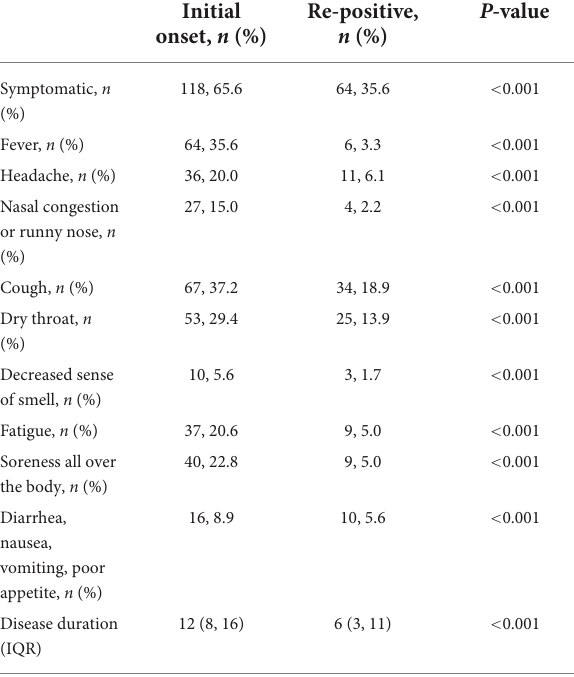
TABLE 1 Comparison of clinical symptoms between initial onset and re-positive